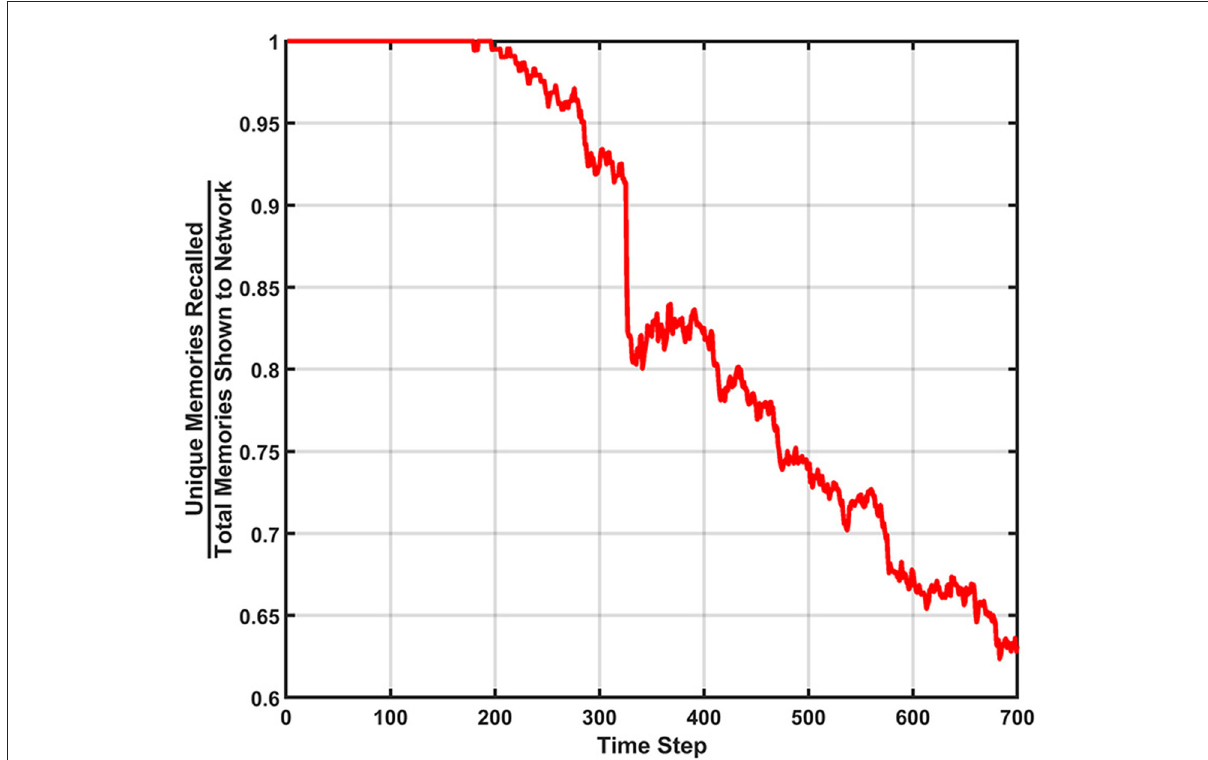
FIGURE12 Unique memory ratio for the behavior ensemble simulation of the SAN. The erasure event can be seen in the steep drop in the ratio. The decay rate’s effect can also be seen in the degradation of the ratio over